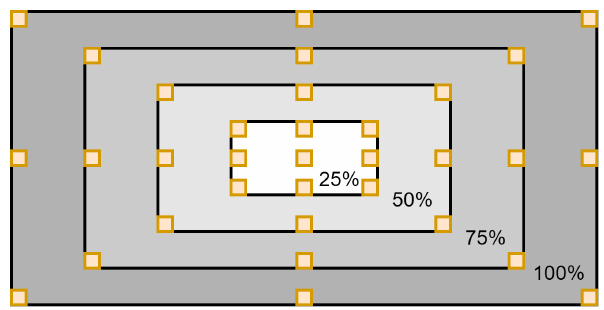
Figure 14. Target positions for full AR